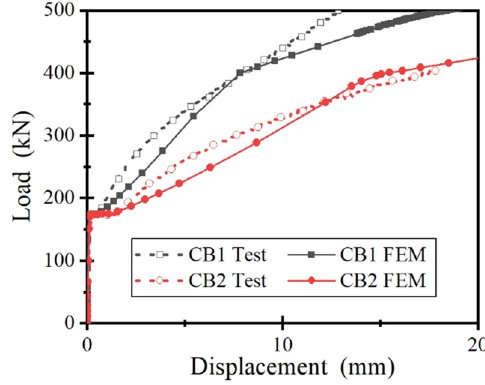
Figure 12: Constitutive relation of mild steel. Figure 13: FE model veri fi cation using material